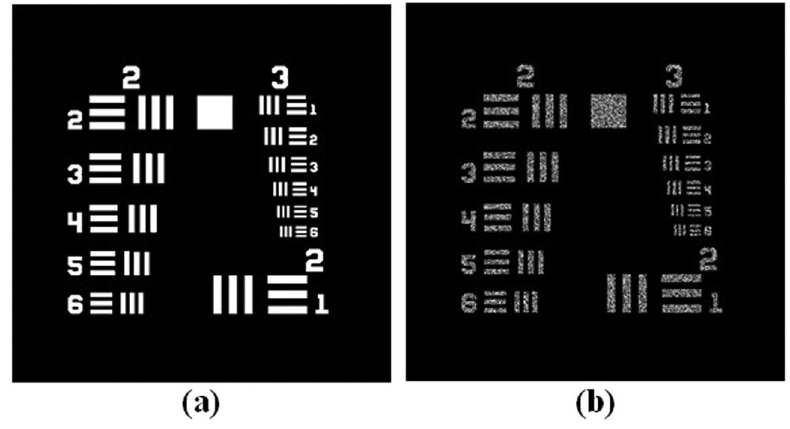
Figure 2: Original USAF resolution chart ( a ) amplitude and ( b ) corresponding phase.